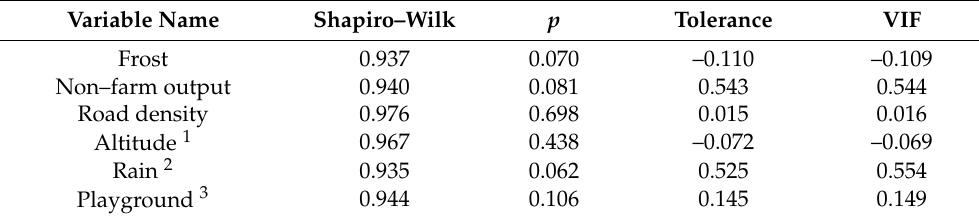
Table 2. Tests for normality and covariance of factors influencing physical